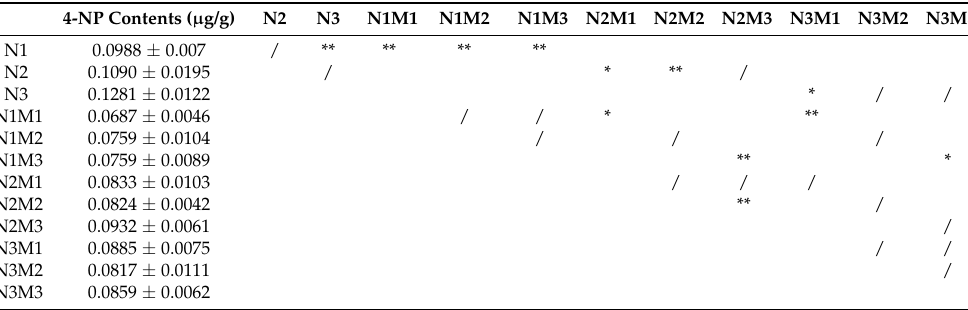
Table 10. Statistical analysis of 4-NP contents in gill at Day 15.